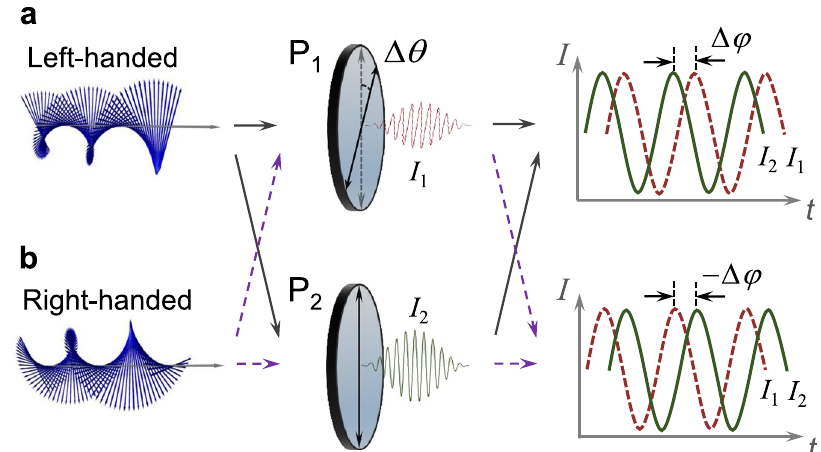
Fig. 2 Two-dimensional DPSs can be detected by two polarizers to determine both the magnitude and direction of the motion vector. a The left-handed DPS passing through two polarizers (P 1 and P 2 ) gives a fi xed relative phase difference (RPD) between the detected Doppler intensity signals 1 and 2 ( I 1 and I 2 ), known as Doppler phase shift. b The right-handed DPS passing through P 1 and P 2 gives an opposite Doppler phase shift between I 1 and I 2 , relative to the former.